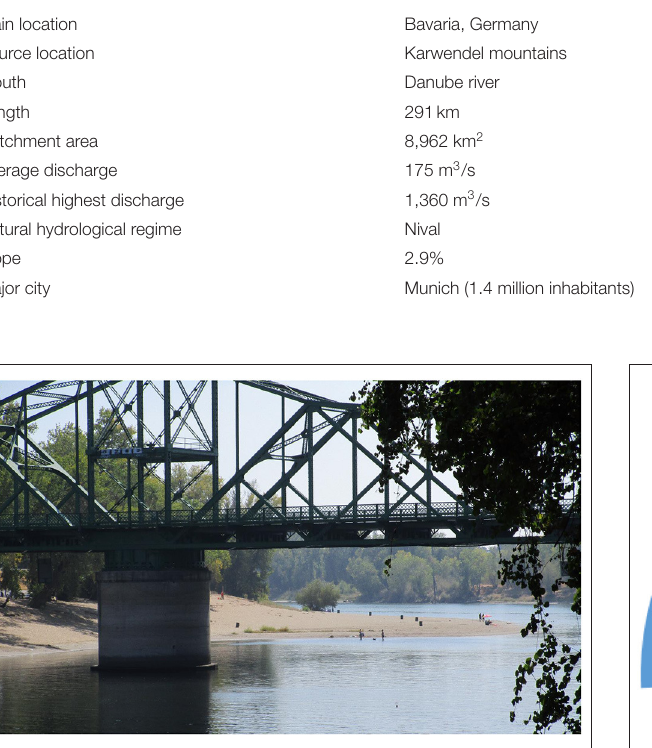
capital of the U.S. state of California, whose economy would rank 5th in GDP globally if it were an independent country.